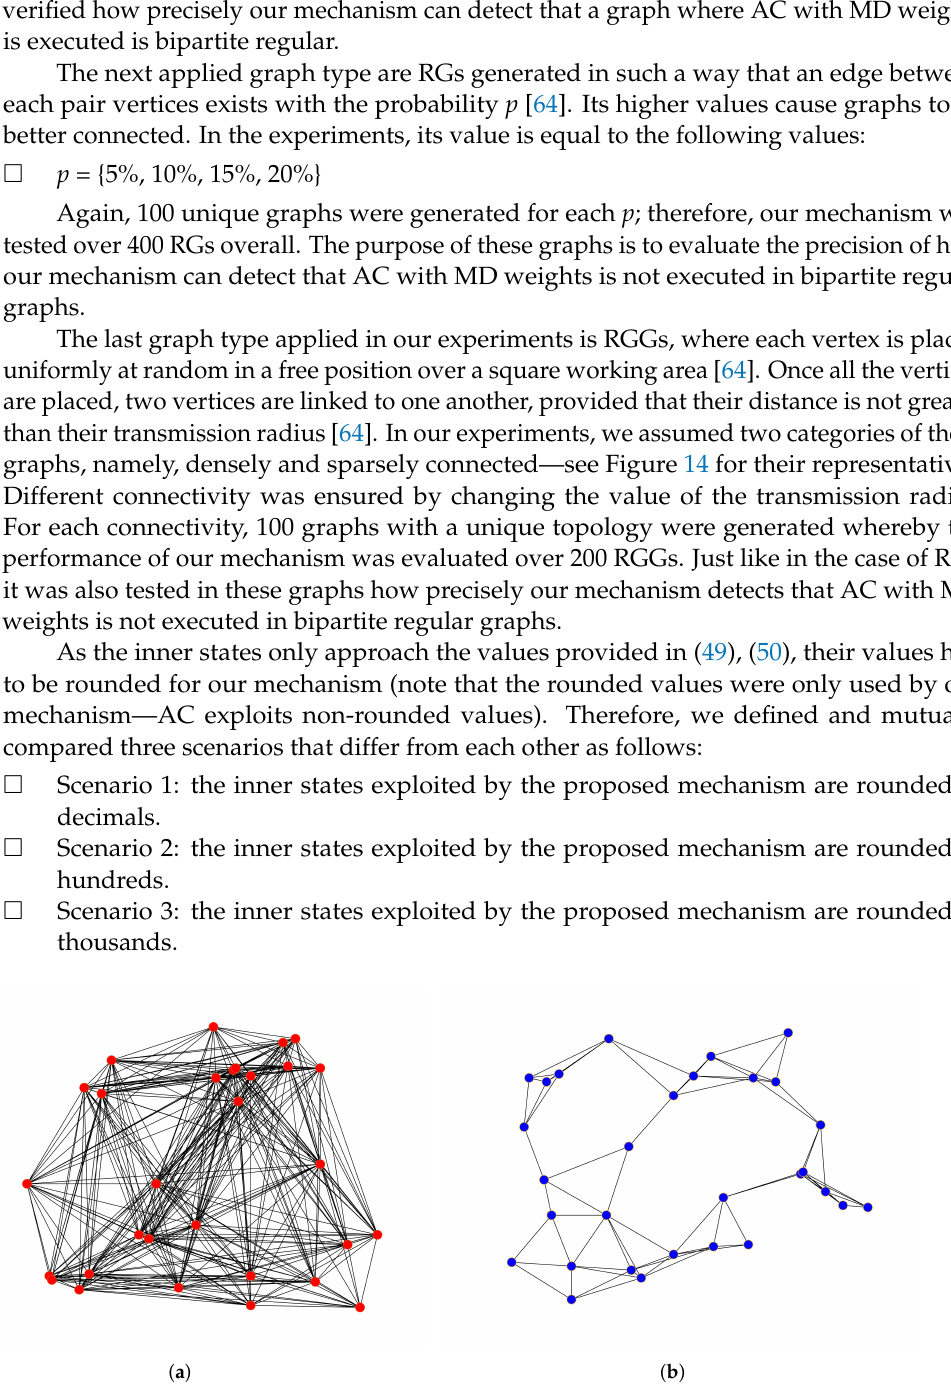
Figure 14. Example of densely and sparsely connected random geometric graphs. ( a ) Dense graph connectivity. ( b ) Sparse graph